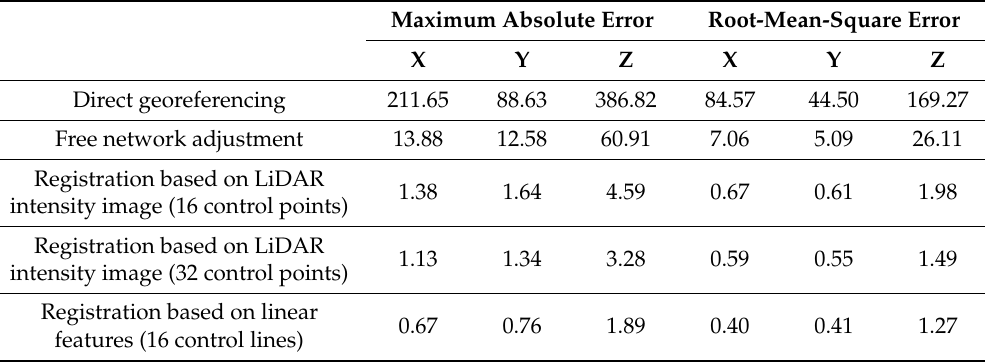
Table 3. Positioning accuracies of the UAVRS images in different scenarios (unit: